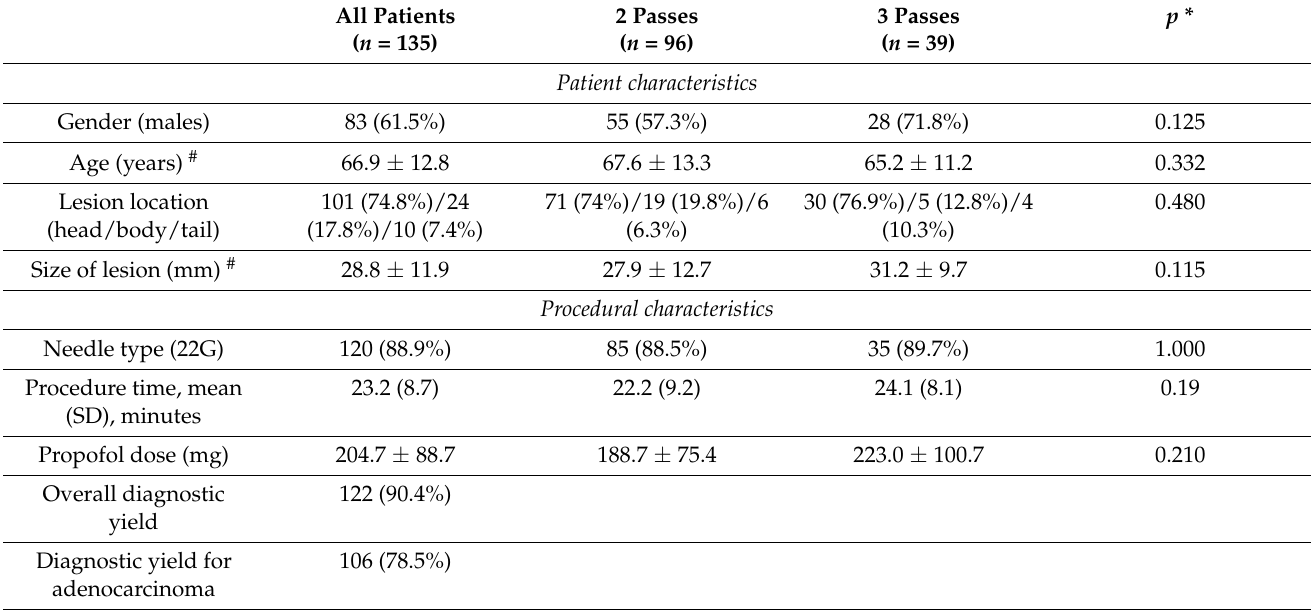
Table 1. Patient’ baseline clinical and procedural characteristics.